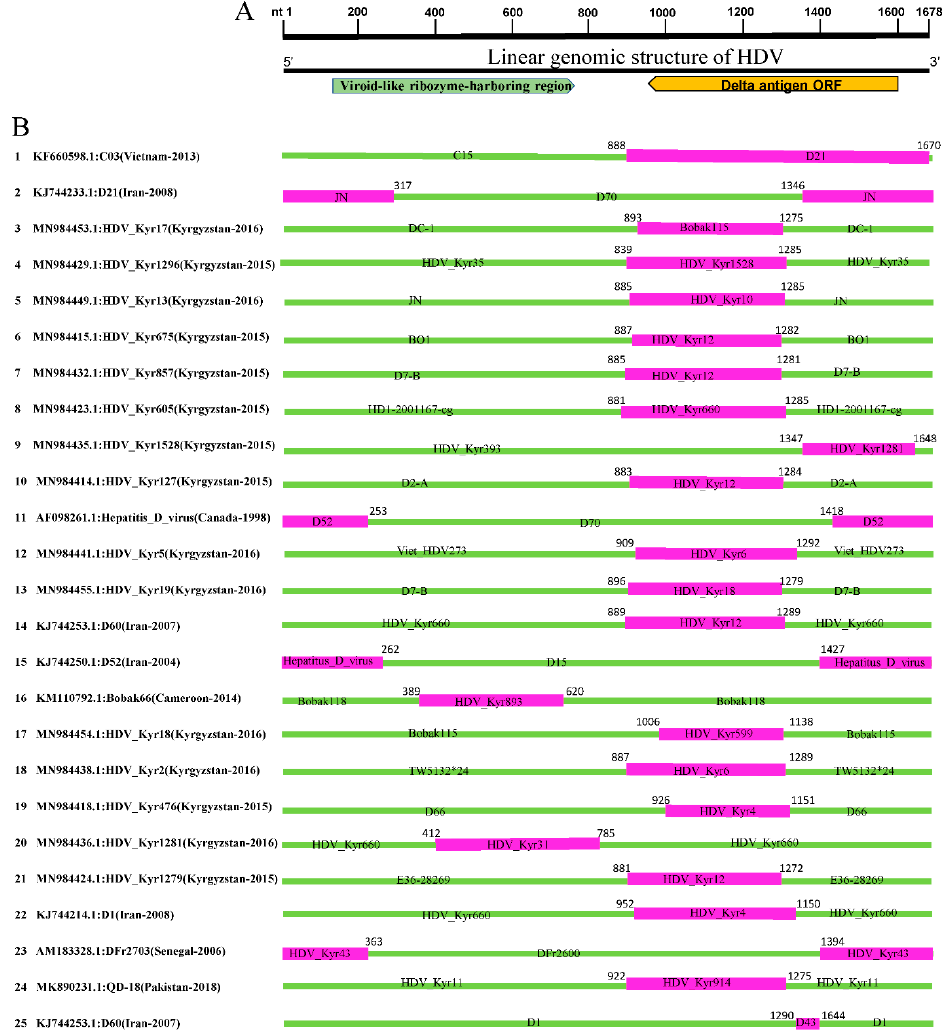
Figure 3. Recombination map across the human HDV genomes for recombination events 1–25. ( A ) Linear genomic structure of HDV full-length sequences (1678 nt). ( B ) Diagram indicating natural recombination events 1–25 detected using the RDP4 software. The numbers on the left indicate the serial number of recombination events. Regions of the major and minor parental sequences are in- dicated by the green and pink blocks, respectively. Numbers on the top of the blocks indicate the nucleotide positions of breakpoints relative to the full-length genome sequence of the corresponding recombinant viruses.